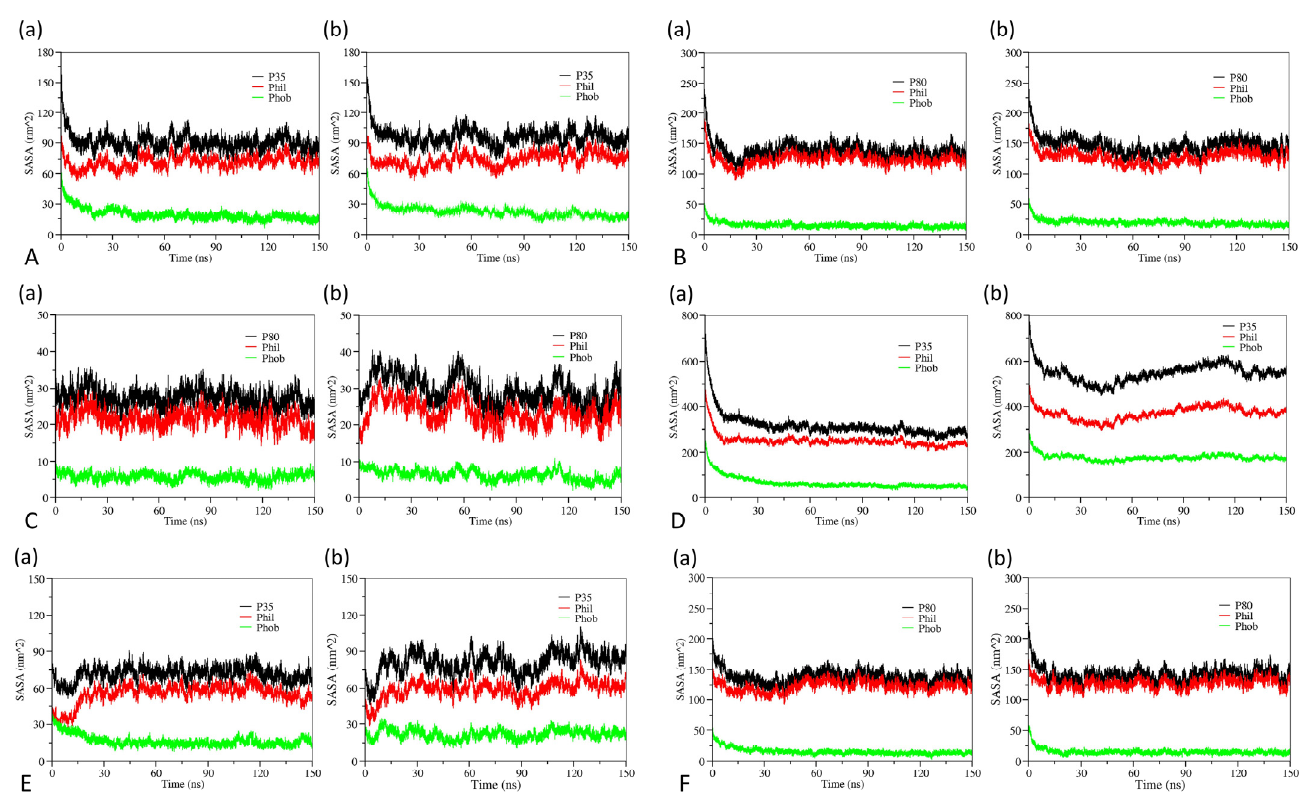
Figure 10. The hydrophilic (green) and hydrophobic (orange) chains of ( a ) Polyoxyl 35 castor oil and ( b ) Polysorbate 80.